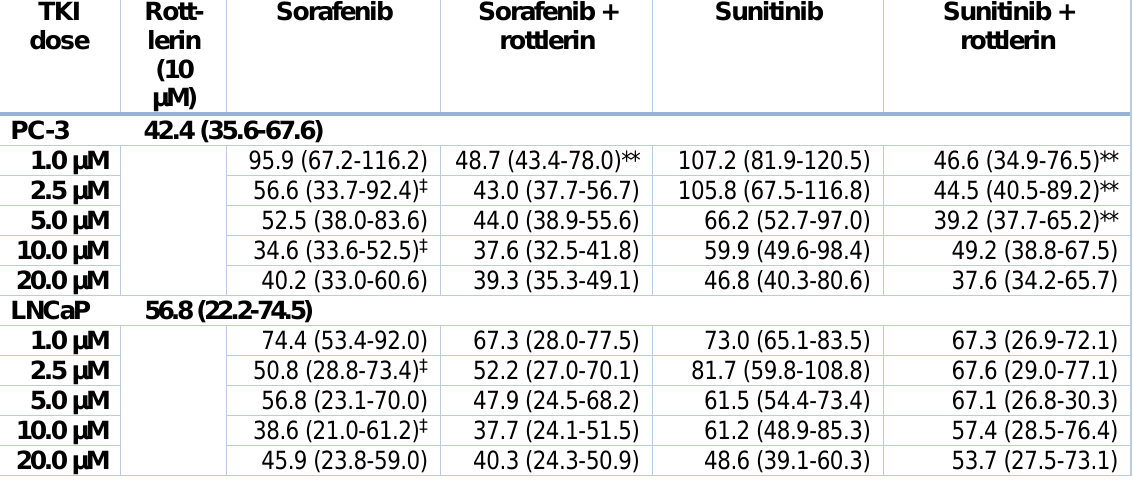
Table 2: Proliferation of PC-3 and LNCaP prostate cancer cells exposed to various concentrations of sorafenib and sunitinib with/without rottlerin (10 µM), determined by BrdU incorporation. The results are presented as medians (interquartile ranges) of the activity in the percentage of unexposed control cells. TKI